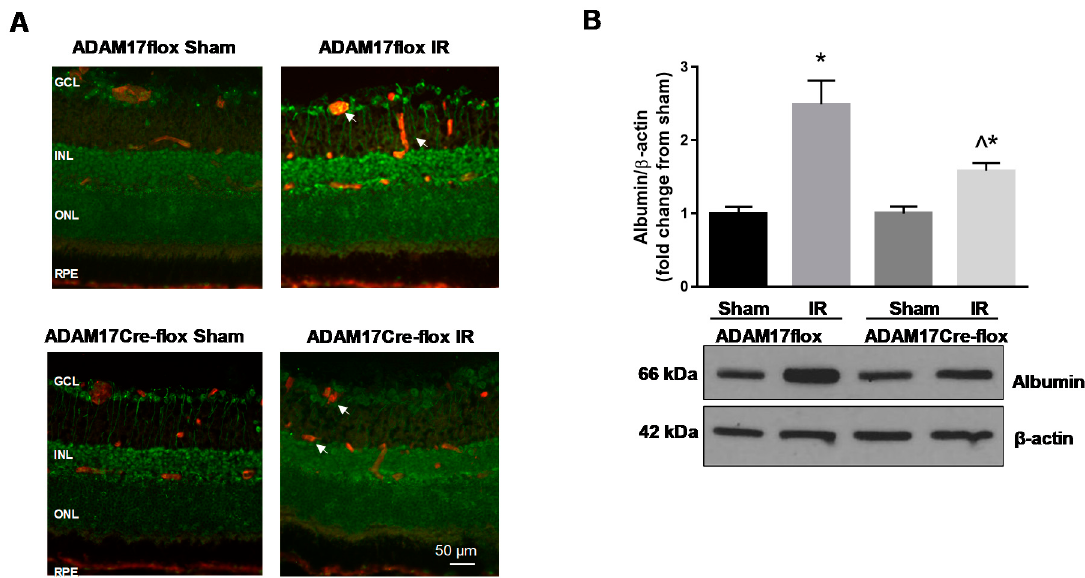
Figure 2. IR-induced vascular leakage is diminished in mice with conditional inactivation of ADAM17 in vascular endothelium. ( A ) Representative immunofluorescence images of ADAM17 expression (green) in retinas of control ADAM17flox and ADAM17Cre-flox mice following IR. Retinal blood vessels (white arrows) were co-labeled with anti-CD31 antibody (red); n = 3 in each group. Scale bar, 50 µm. ( B ) Western blotting analysis of extravascular albumin in retinal tissue of ADAM17flox and ADAM17Cre-flox mice was performed 48 h after IR. Blots were subjected to densitometric analysis and the obtained data were analyzed for statistical significance. Actin was used as an internal control. Values are mean ± SE. Results are presented as fold of change from sham. * p < 0.01 vs. corresponding sham; ^ p < 0.001 vs. ADAM17flox IR; n = 5 in each group.